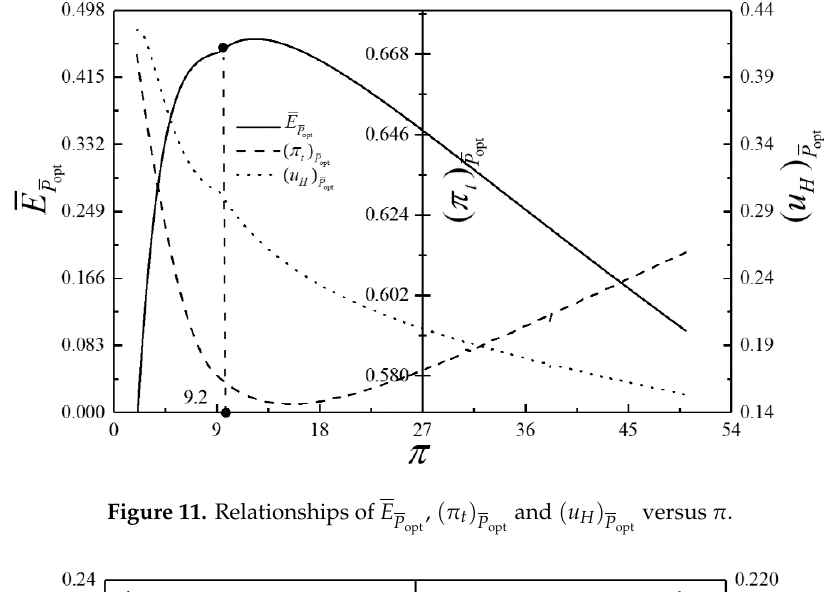
Figure 10. Relationships of W and versus